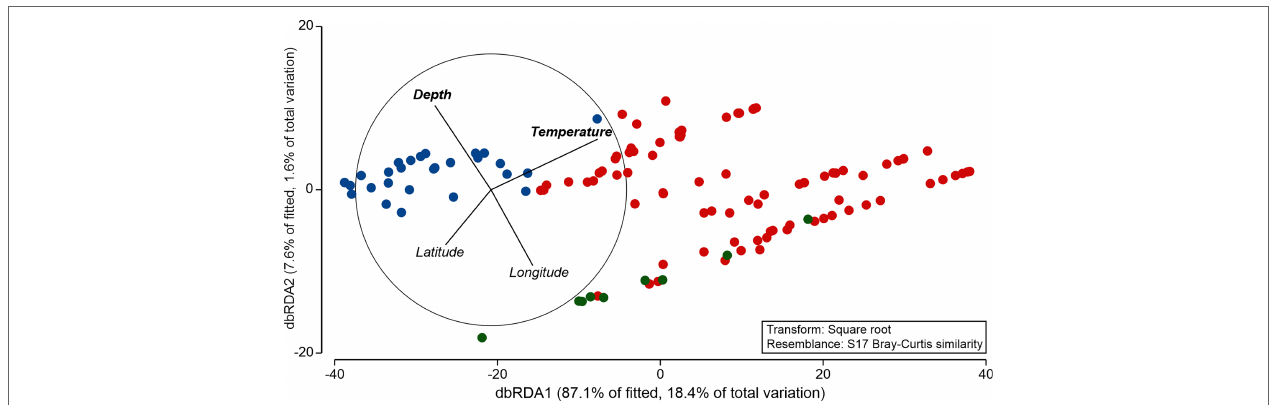
FIGURE 6 | Similarity of the gelatinous zooplankton community in the frontal zones (W—blue, C—red, and E—green) along environmental gradients resolved by distance-based redundancy analysis (dbRDA). Variables in bold were statistically significant according to the DistLM